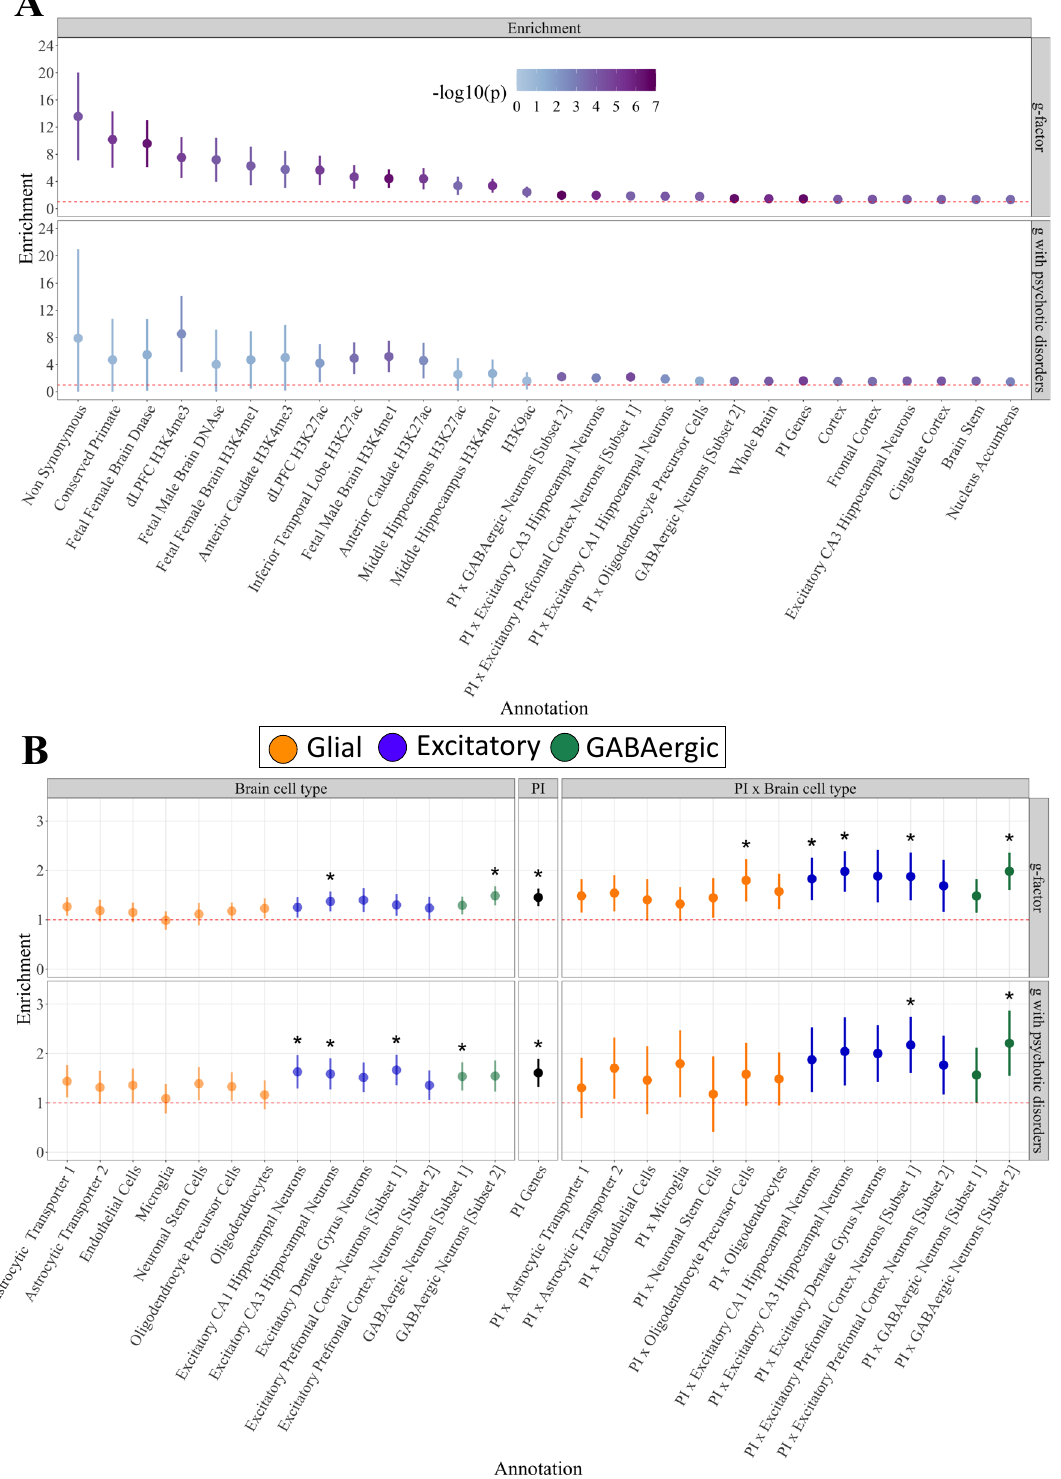
Fig. 2 | Multivariate enrichment. Panel A displays the 28 annotations for the g- factorthatweresigni fi cantatBonferronicorrectedthresholdfor155tests.Dotsare orderedaccordingtothesizeoftheenrichmentpointestimateforthe g -factorand shaded to re fl ect the level of signi fi cance. Panel B depicts the PI×brain cell anno- tationsandorderstheestimatesbybraincelltype,PIgenes,andPI×braincelltype interactions. Glial cells are depicted in orange, excitatory cells in blue, and GABAergic cells in green. Dots that were signi fi cant at a Bonferroni-corrected